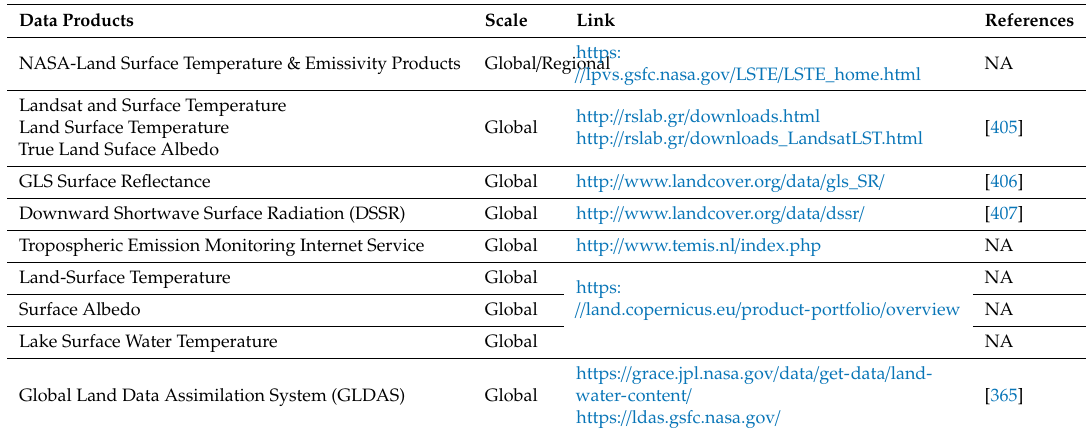
Figure 12. Current and future spaceborne RS missions and satellites for monitoring land surface temperature with information about the mission status, information by the CEOS database [205]. A selection of RS-aided data products for deriving LST from RS is shown in Table 8. Table 8. Selection of RS-aided data products of land surface temperature and related variables.